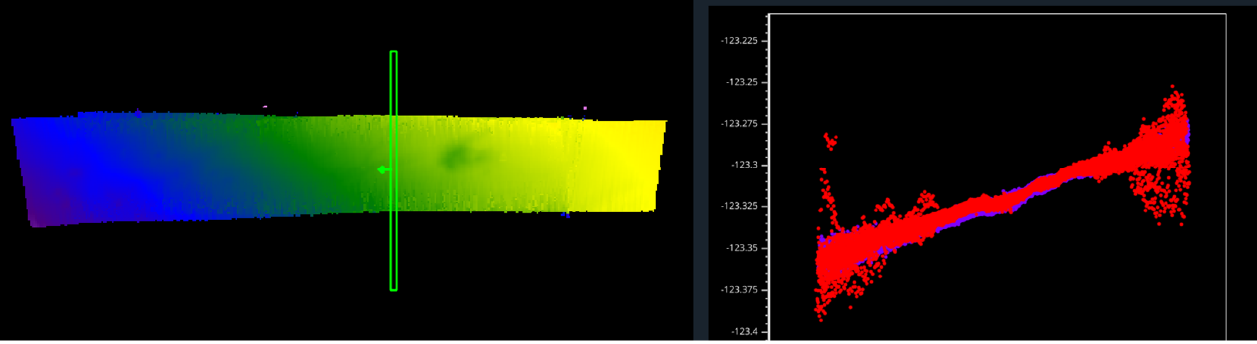
Figure 8. Patch Test utility shown, with data being assessed for roll mounting angle offset.